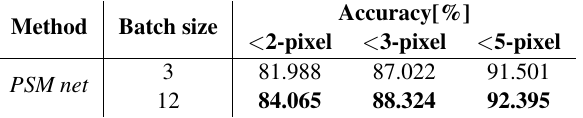
Table 2. Influence of the batch for PSM net . Method